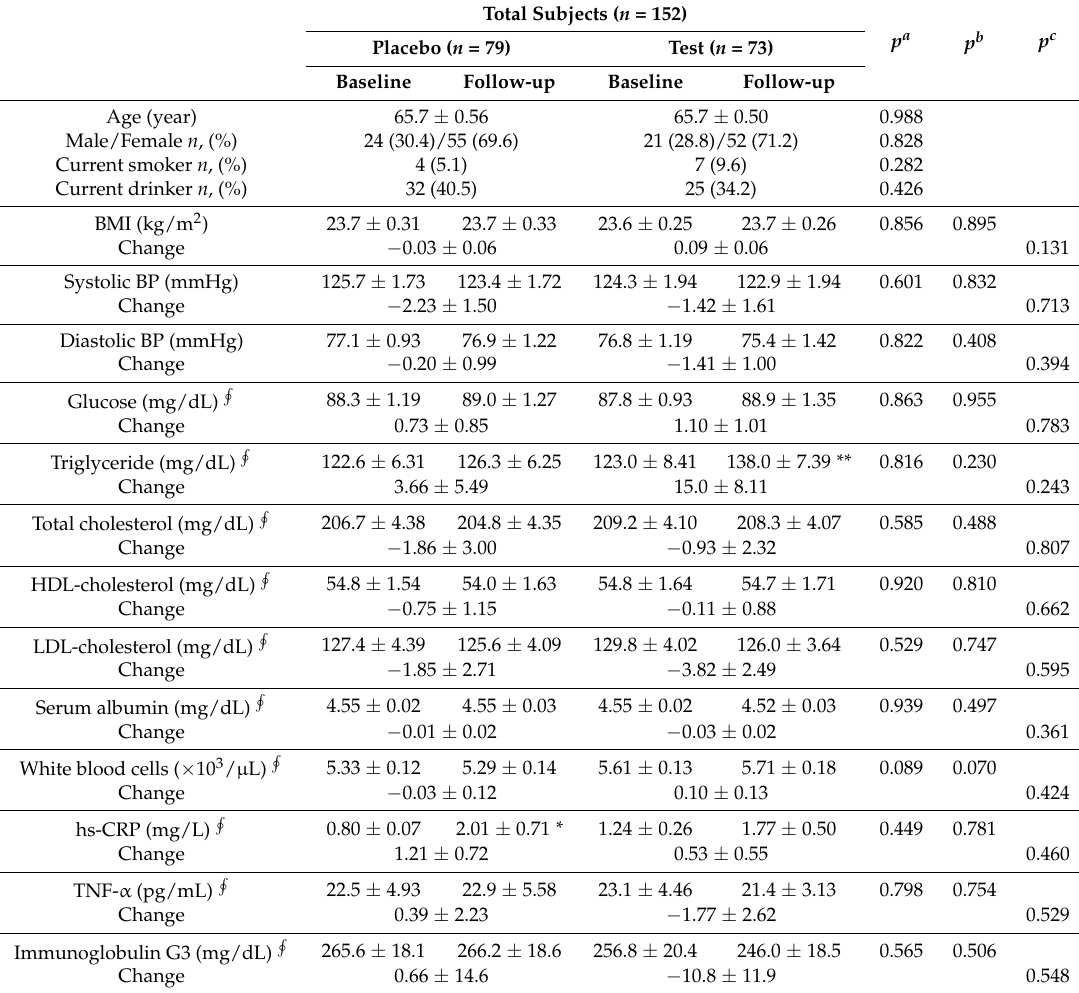
Table 1. Effects on clinical and biochemical characteristics following 12 weeks of consuming dairy yogurt containing L. paracasei , B. lactis and heat-treated L. plantarum